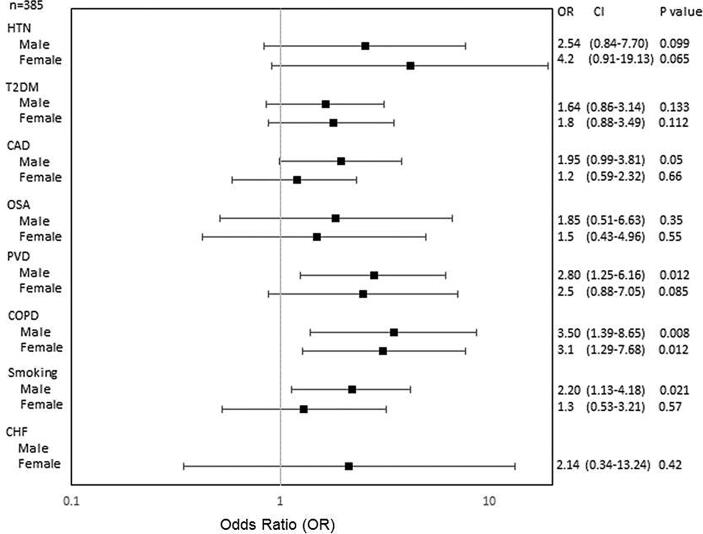
Impact of age-adjusted AF risk factors on stroke in Hispanics/Latinos (H/Ls). Abbreviations as in Fig. 2a.